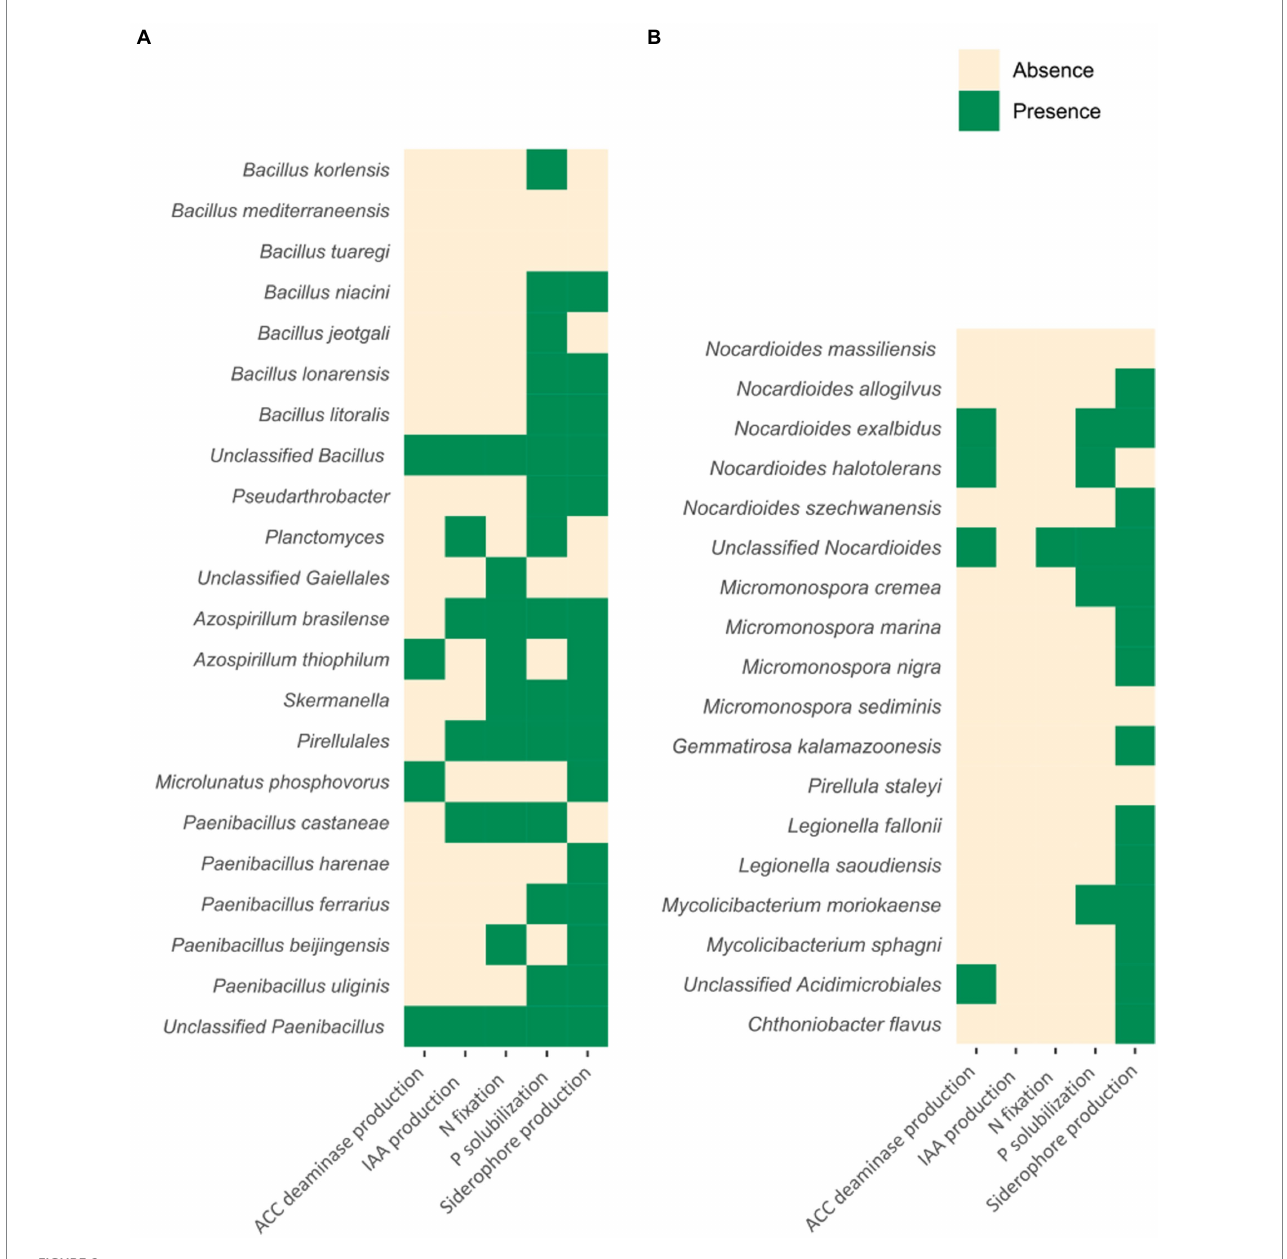
FIGURE 6 Schematic illustration showing the potential presence of PGP traits within the genomes of PDO-related (A) and non-PDO related (B) rhizospheric species. Each taxon was tested for the presence/absence of a specific set of PGP functions. The selected functions were nitrogen fixation, phosphorous solubilization, iron chelation, production of indole-3-acetic acid (IAA), and production of 1-aminocyclopropane-1-carboxylic acid (ACC) deaminase. Green squares for putative presence of PGP activities, ivory squares for absence of PGP